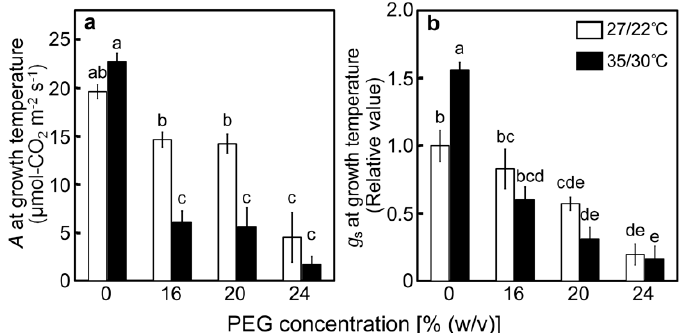
Figure 2. Rate of CO 2 assimilation ( A ) ( a ) and stomatal conductance ( g s ) ( b ) after drought stress treatment under two different temperature conditions in rice. Approximately 60 days after germination, hydroponically grown plants were drought-stressed using culture solutions containing PEG at 0, 16, 20, 24% ( w / v ) for two days under an irradiance of 450 μ mol photon m − 2 s − 1 and day/night air-temperatures of 27/22°C or 35/30°C, followed by measurements of A and g s . Measurements were made under conditions of an actinic light intensity of 1250 μ mol photon m − 2 s − 1 , [CO 2 ] of 40 Pa, leaf temperature of 27°C (white bar) or 35°C (black bar), which corresponded to the daytime air temperature during stress treatment, and relative humidity of 60–70%. Data are presented as means ± SE ( n = 3 to 5). Statistical analysis was carried out by ANOVA, followed by Turkey-Kramer’s test. Columns with the same letter were not significantly different ( p < 0.05).